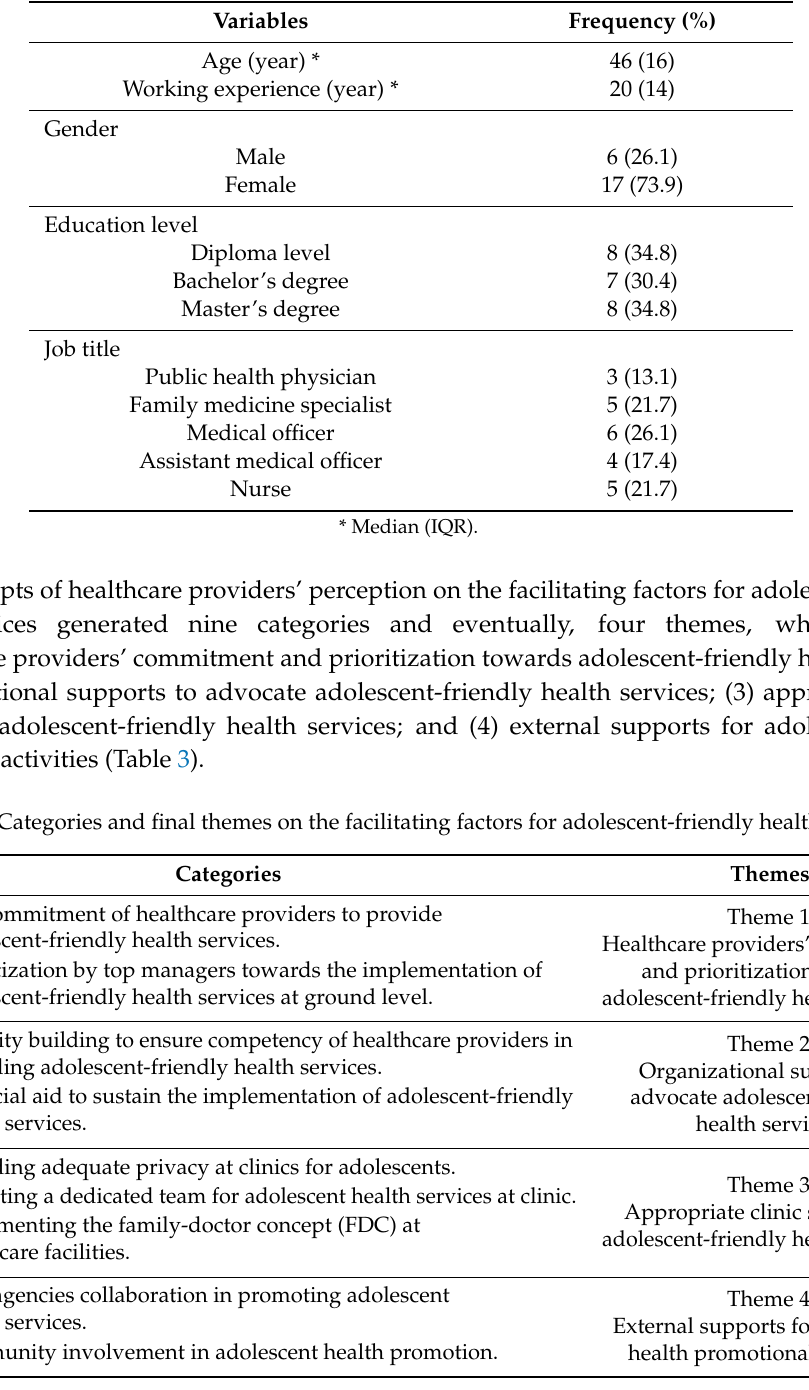
Table 2. Attributes of qualitative participants ( n = 23).